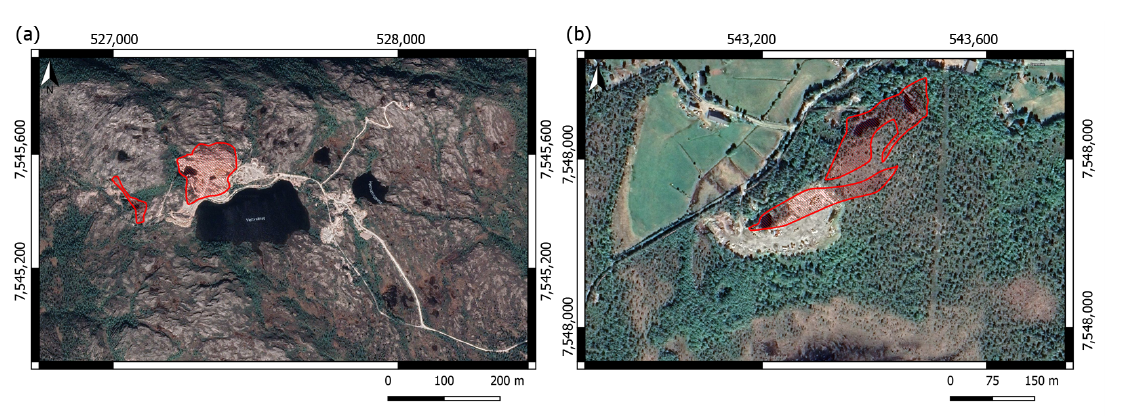
Figure 7. Outcrop of pegmatites identified in red polygons. ( a ) Pegmatite outcrop at Håkonhals. ( b ) Pegmatite outcrop at Jennyhaugen. The area outside the pegmatite outcrop and within the mining areas may also contain pegmatitic materials.